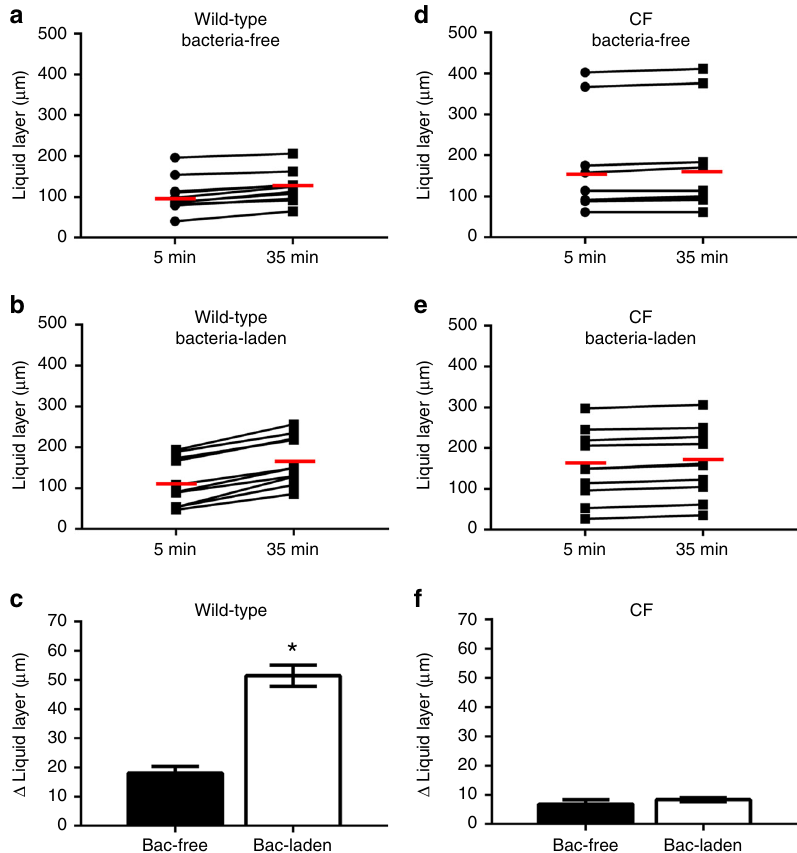
Fig. 2 CFTR − / − swine fail to respond to Pseudomonas aeruginosa in vivo. Scatter plot and median ( red line ) of the effect of a bacteria-free and b bacteria- laden agarose beads on the ASL layer of wild-type swine. Bacteria-free beads trigger an ASL increase from 105 to 123 µ m ( P < 0.05, n = 10 from seven pigs, Wilcoxon match-pairs signed rank test) while bacteria-laden beads triggered a height increase from 117 to 168 µ m ( P < 0.05, n = 10 from six pigs, Wilcoxon match-pairs signed rank test). c Increase in ASL height triggered by bacteria-laden ( n = 10) and bacteria-free ( n = 10) agarose beads ( P < 0.0001, t = 7.76, df = 18, Student ’ s t -test). Effect of d bacteria-free and e bacteria-laden agarose beads on the ASL layer of CFTR − / − swine. Bacteria-free beads trigger an ASL increase from 172 to 178 µ m ( P < 0.05, n = 9 from six pigs, Wilcoxon match-pairs signed rank test) while bacteria-laden beads triggered a height increase from 150 to 158 µ m ( P < 0.05, n = 11 from eight pigs, Wilcoxon match-pairs signed rank test). f The increase in ASL height triggered by bacteria- laden ( n = 11) and bacteria-free ( n = 9) agarose beads were not signi fi cantly different in CFTR − / − swine ( P = 0.49, Mann – Whitney test). Data are presented as mean ± SEM and within each panel the columns labeled with an asterisk differ signi fi